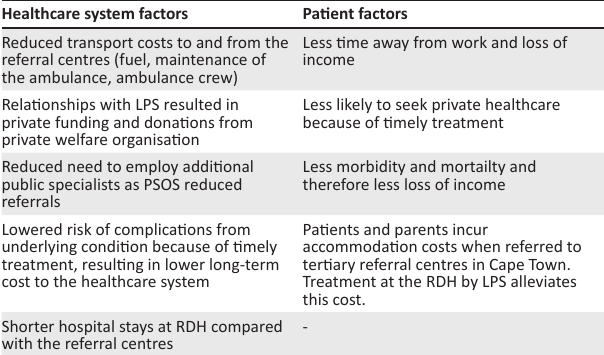
TABLE 6: The financial benefits of private specialist outreach and